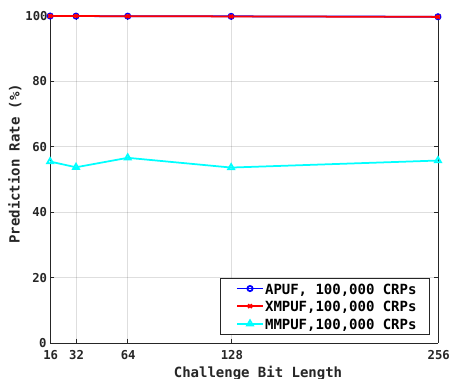
Figure 7. The prediction rates of LR attacks on 64-bit PUF designs ( σ n = 0) by using 100,000 CRPs and applying different challenge bit